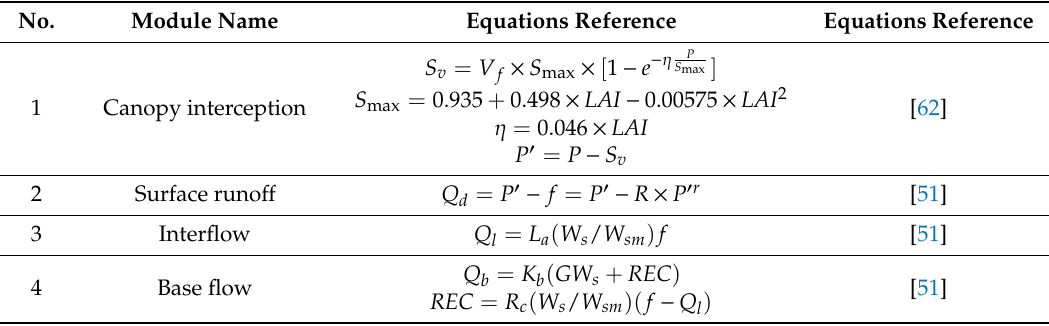
Table 1. Functions and parameters related to runo ff generation in the Land Catchment Model-Modified Universal Soil Loss Equation (LCM-MUSLE) model.